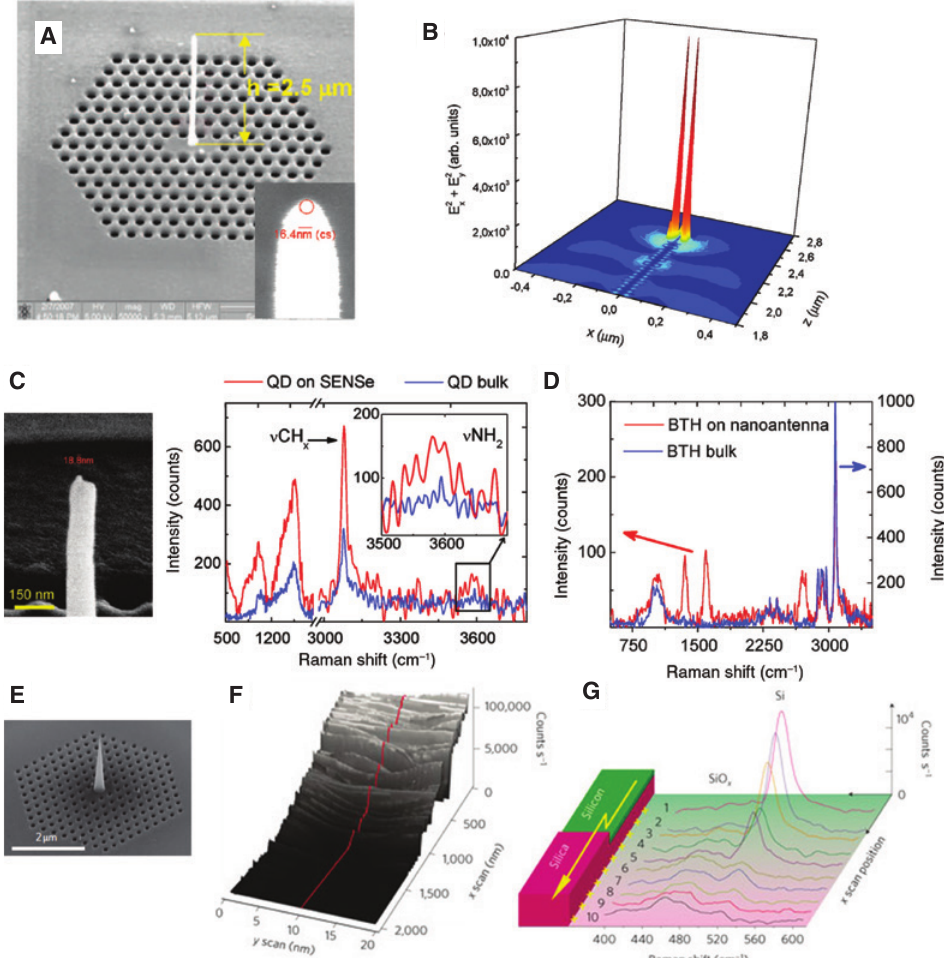
Figure 29: Photonic crystal nanosensor with a plasmonic nanoantenna. (A) SEM micrograph of a surface-enhanced nanosensor with a plasmonic nanoantenna at the centre of an embedded PhC cavity. The inset is an enlarged view of the nanoantenna. (B) Simulated 3D intensity profile along the nanoantenna. (C) To the left is an SEM image of the plas- monic nanoantenna with a deposited core-shell ZnS/CdSe quantum dot at its tip, while to the right is a Raman spectrum taken from single (red) and bulk (blue) quantum dot samples. (D) Confocal Raman scattering measurements on the nanoantenna (red) compared to the bulk spectrum on the benzenethiol monolayer. Adapted from [170]. (E) SEM micrograph of a hybrid photonic-plasmonic nanodevice, i.e. a PhC cavity with a tapered metallic waveguide on an AFM cantilever. (F) and (G) wide-scan Raman spectra and 3D map of the silicon nanocrystal/ SiO surface, respectively. Adapted from x